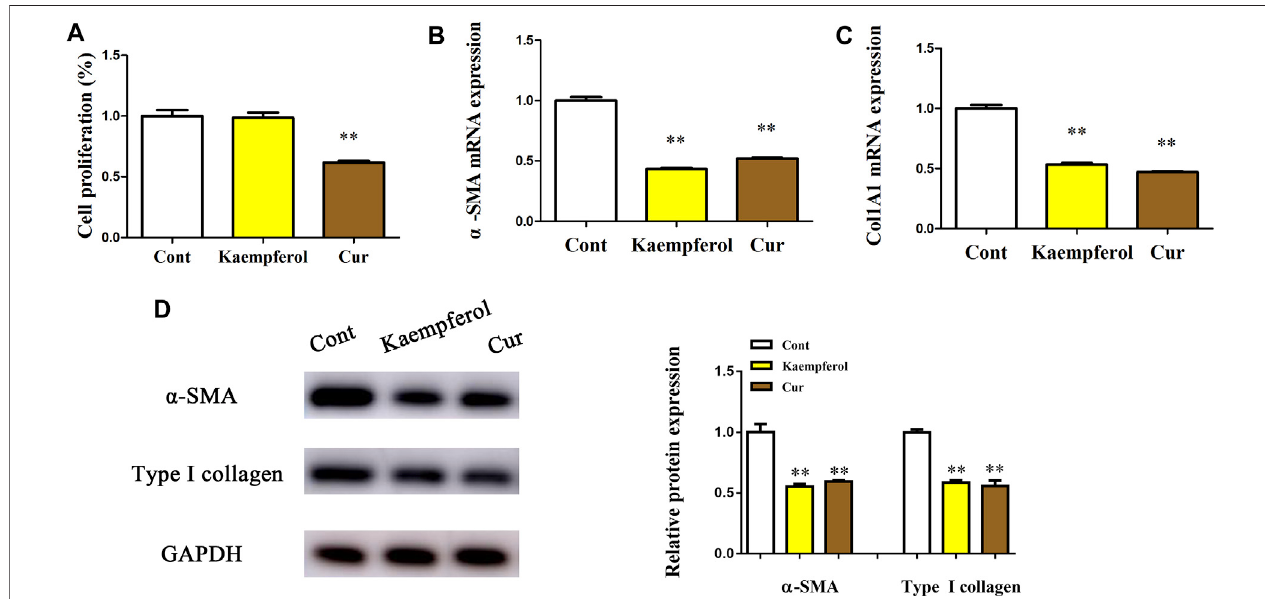
FIGURE 2 | Effects of kaempferol on HSC proliferation and activation. Primary 1-day-old HSCs were treated with 10 μ M kaempferol for 24 h. (A) Cell proliferation. (B) α -SMA mRNA. (C) Col1A1 mRNA. (D) Levels of α -SMA protein and type I collagen. ** p < 0.01 compared with the control.